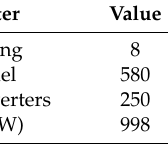
Table 5. Area required for installing the floating PV system according to different angles of array tilt.